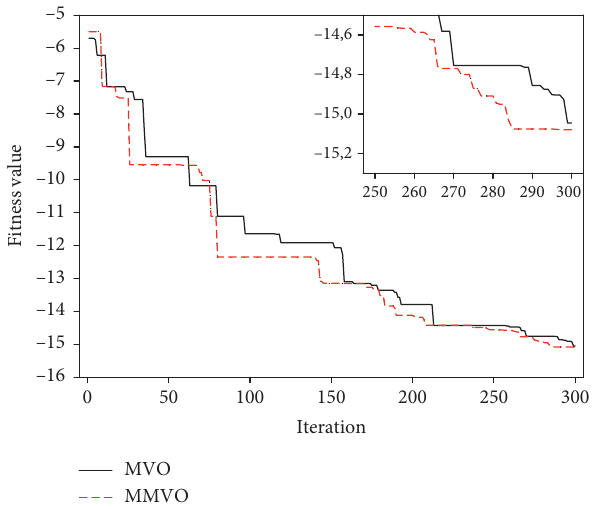
Figure 4: Convergence curve of 8-element CAA.